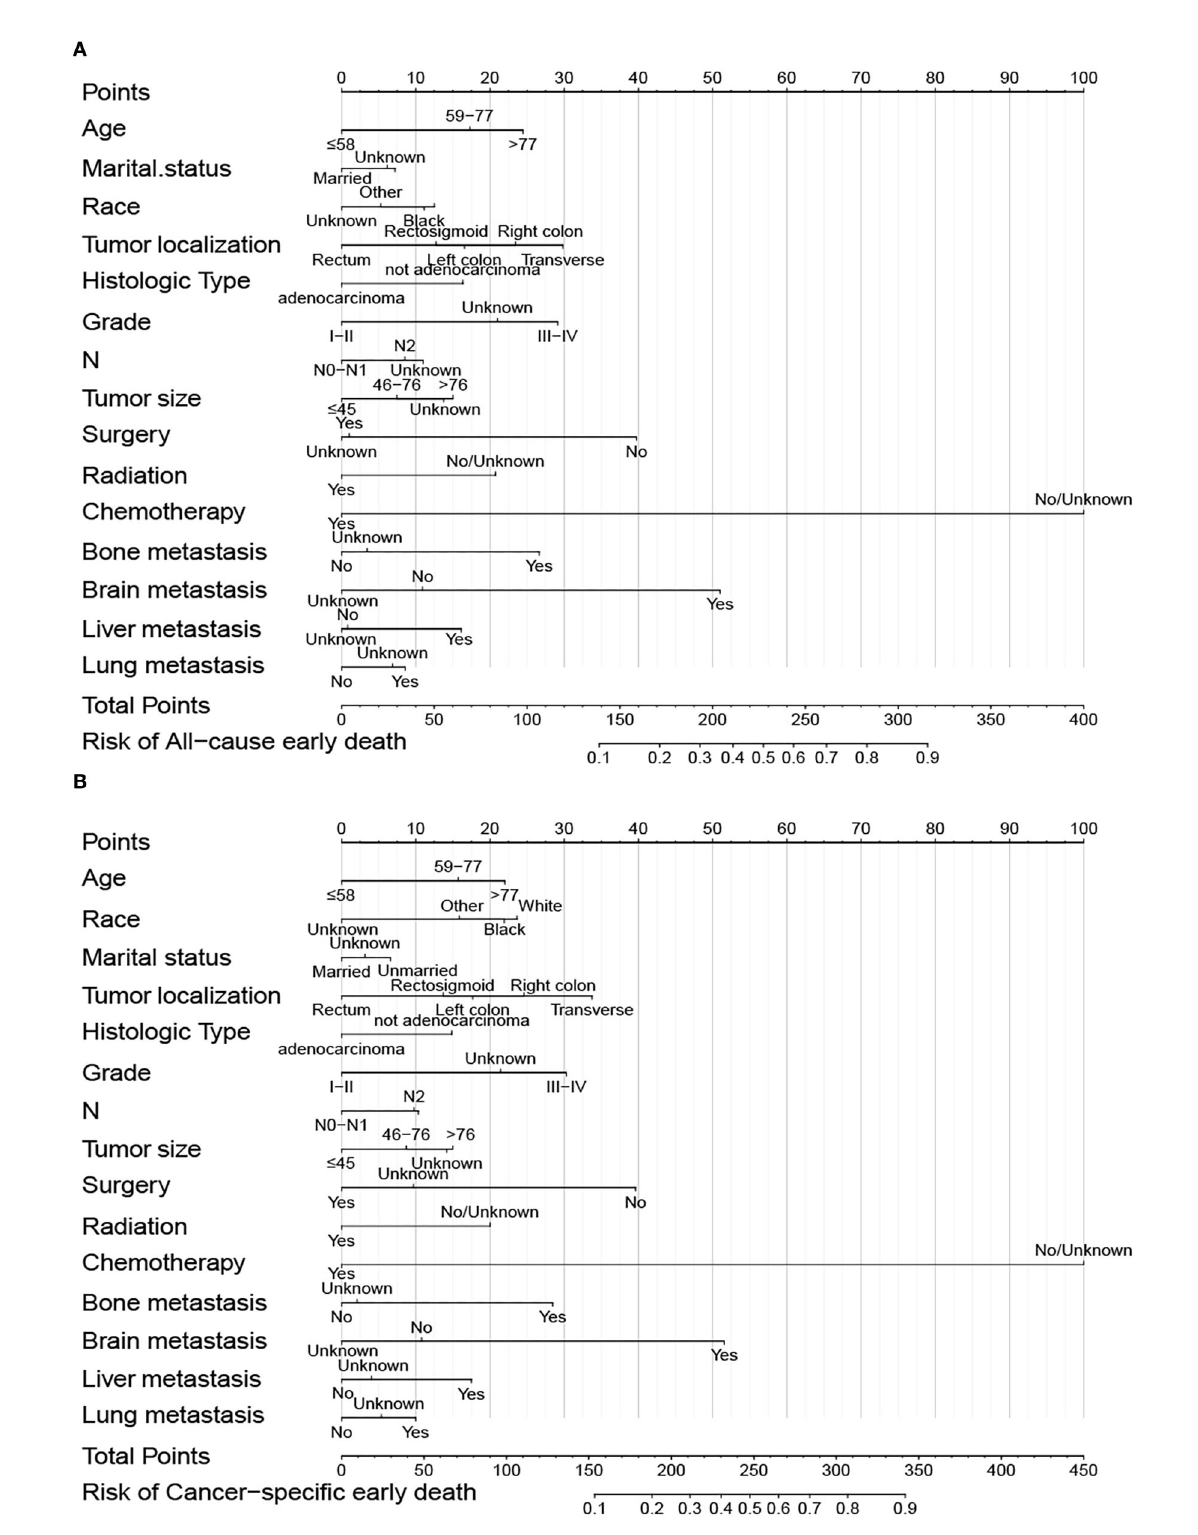
FIGURE4 Nomogram of overall early death (A) and cancer-specific early death (B) of patients with